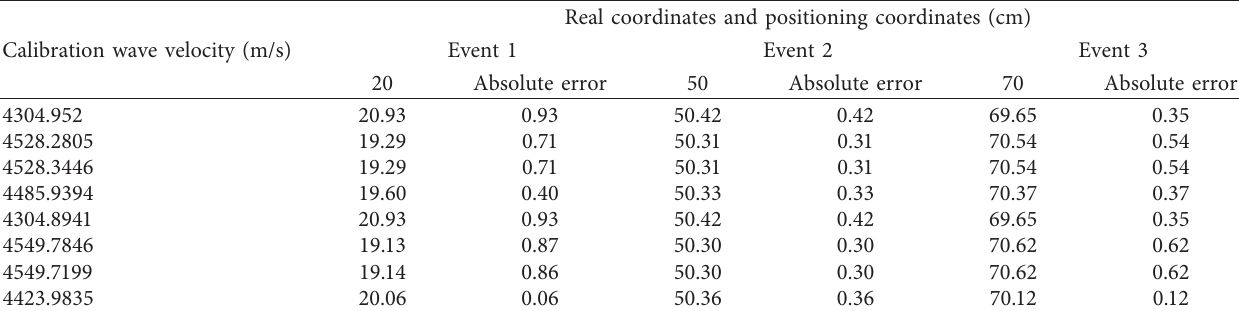
Table 5: The real coordinates and positioning coordinates of line positioning at different wave velocities in GAM.